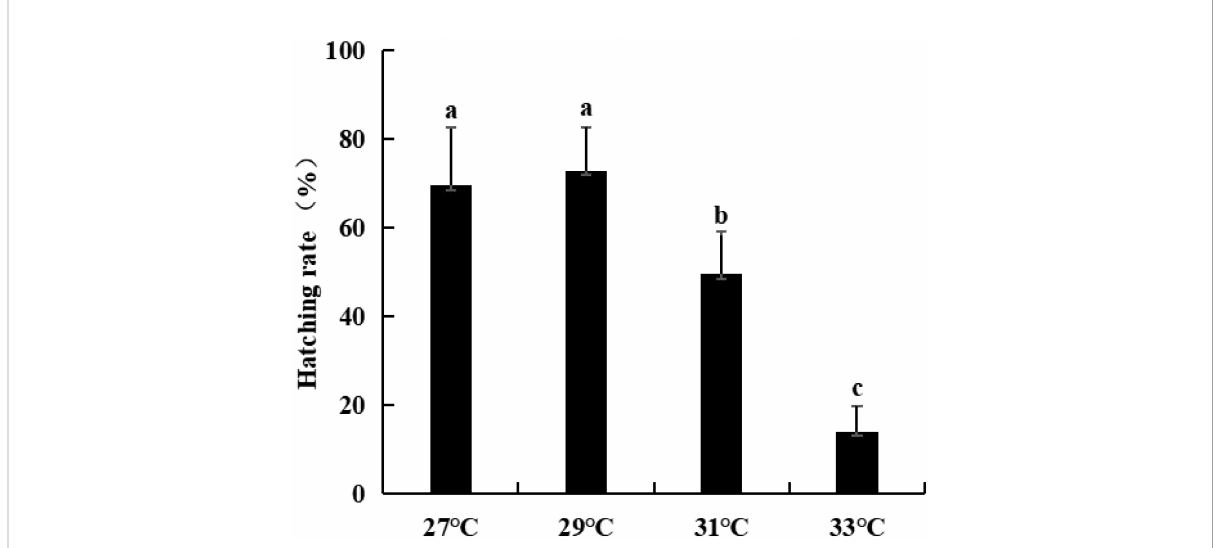
FIGURE 5 Embryo hatching rate of swimming crab at four water temperature. Different lowercase letters above the fi gure column indicate that there are signi fi cant differences between different temperature groups ( P<